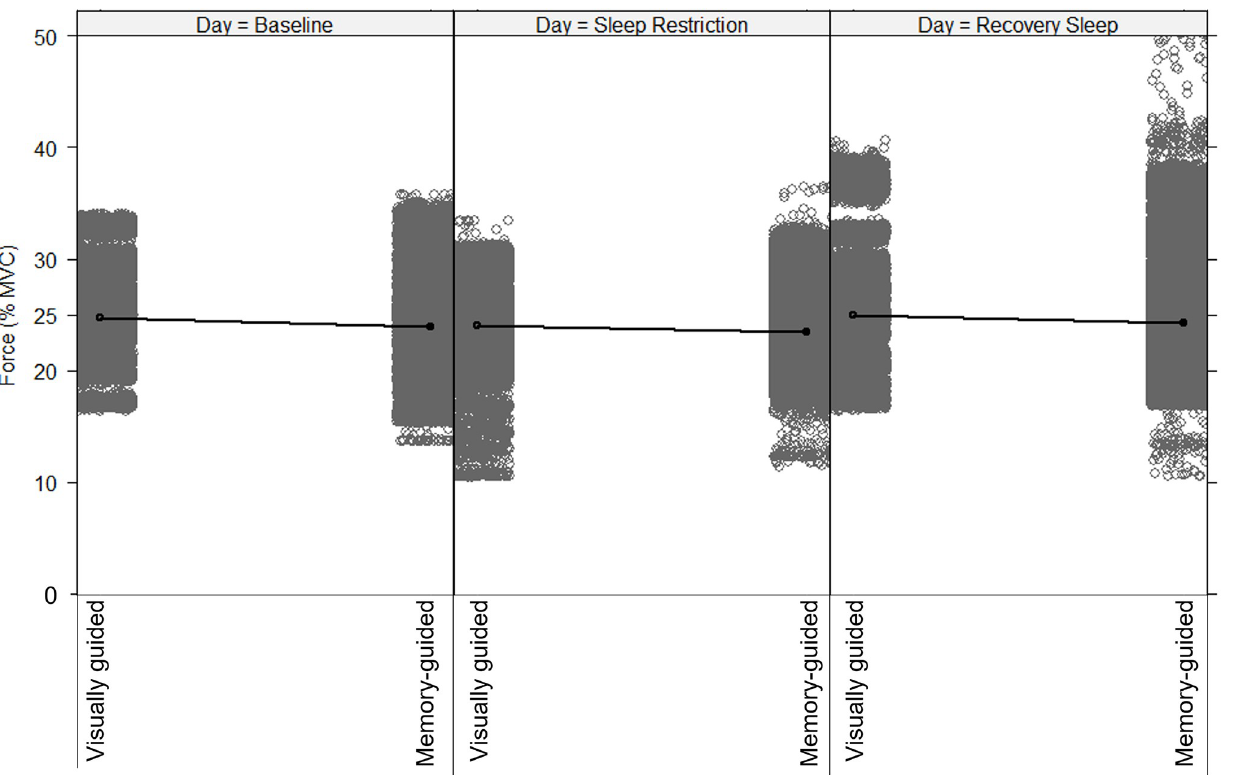
Fig 5. Residuals of the final model across day and vision condition, demonstrating that residual variability in force production was higher in the memory-guided than the visually guided condition after sleep restriction and recovery sleep across participants.